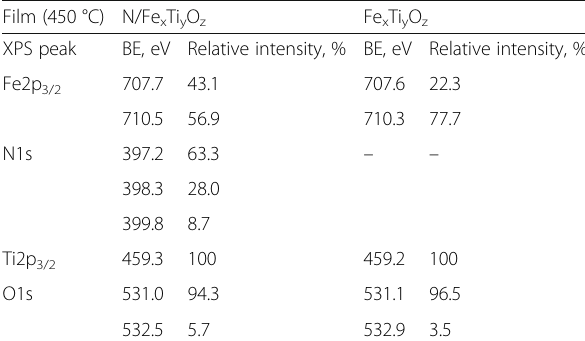
Table 3 Binding energies of the elements detected by XPS and their relative intensity values